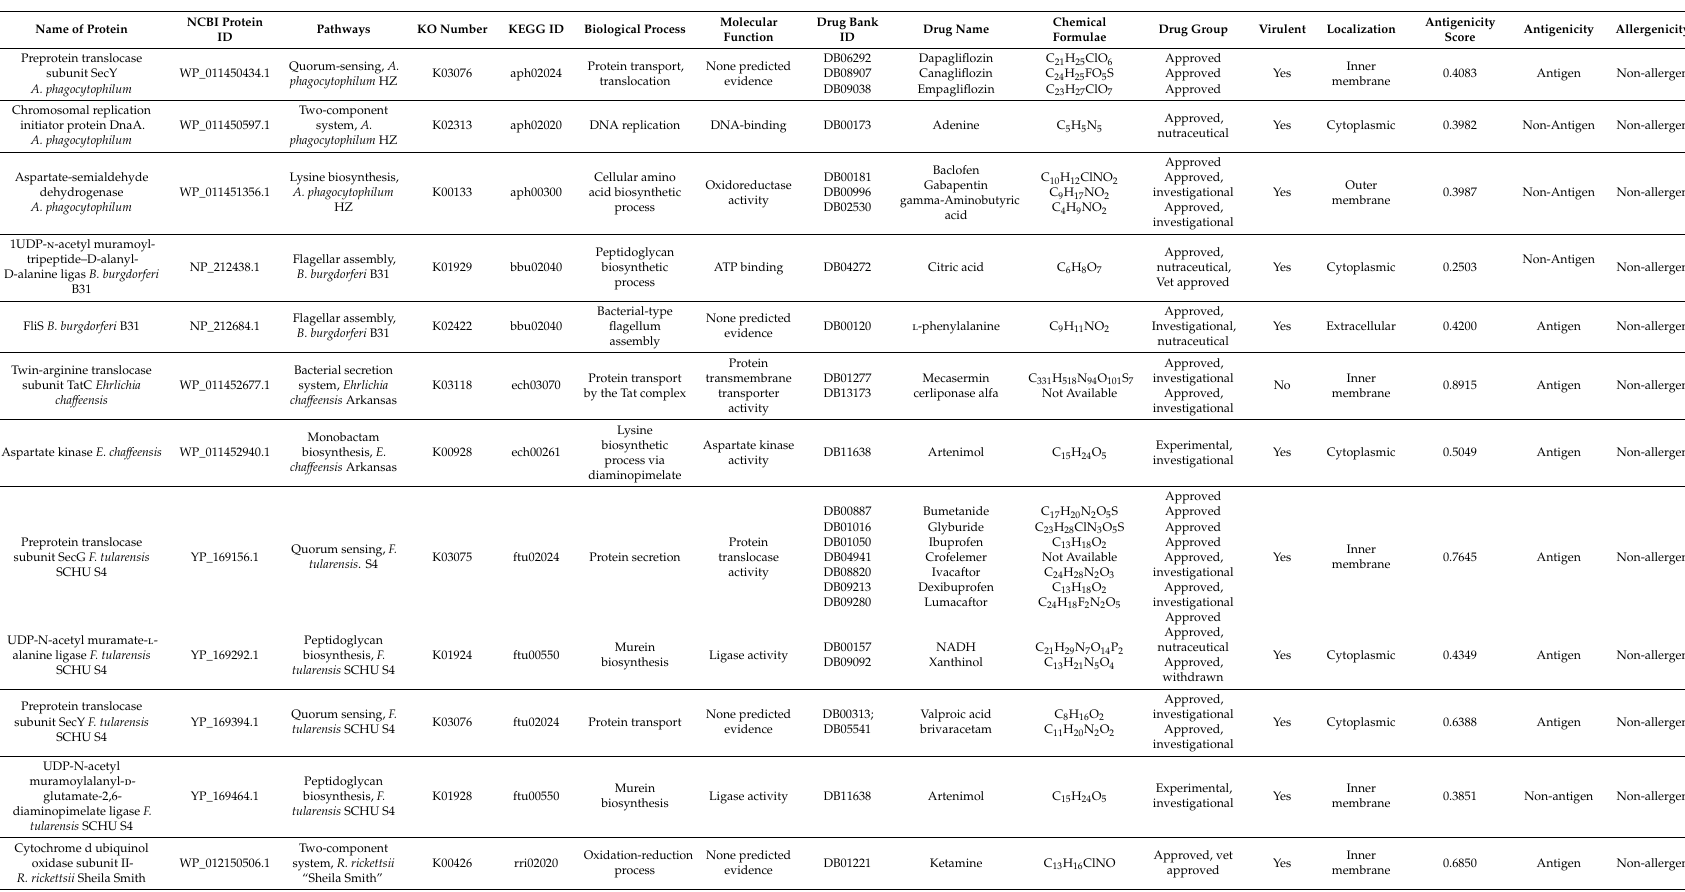
Table 2. List of biological and molecular functions, non-host homologous, essential pathways, subcellular localization, druggability, and antigenicity of identified